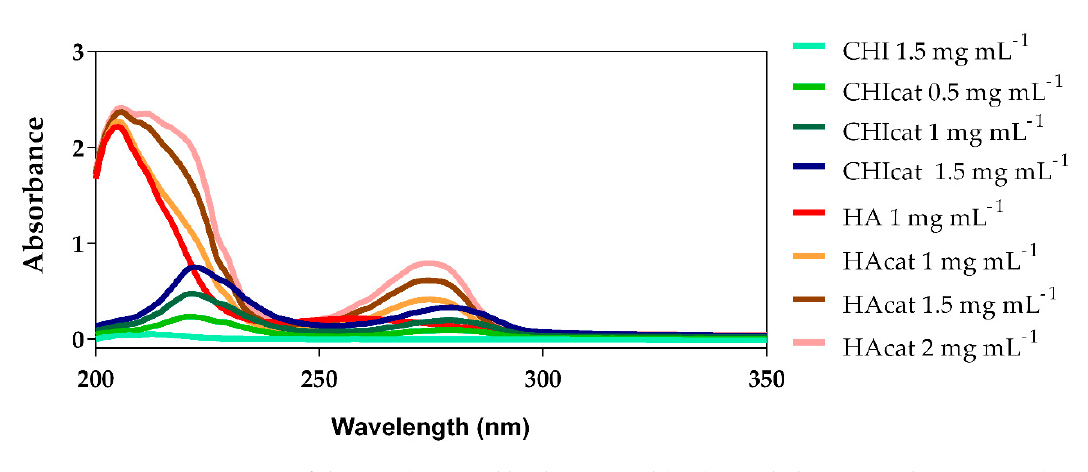
Figure 1. UV-Vis spectra of chitosan (CHI) and hyaluronic acid (HA), catechol-conjugated CHI (CHIcat) and catechol-conjugated HA (HAcat) ( λ = 200–350 Figure 1. UV ‐ Vis spectra of chitosan (CHI) and hyaluronic acid (HA), catechol ‐ conjugated CHI (CHIcat) and catechol ‐ conjugated HA (HAcat) ( λ = 200–350 nm).